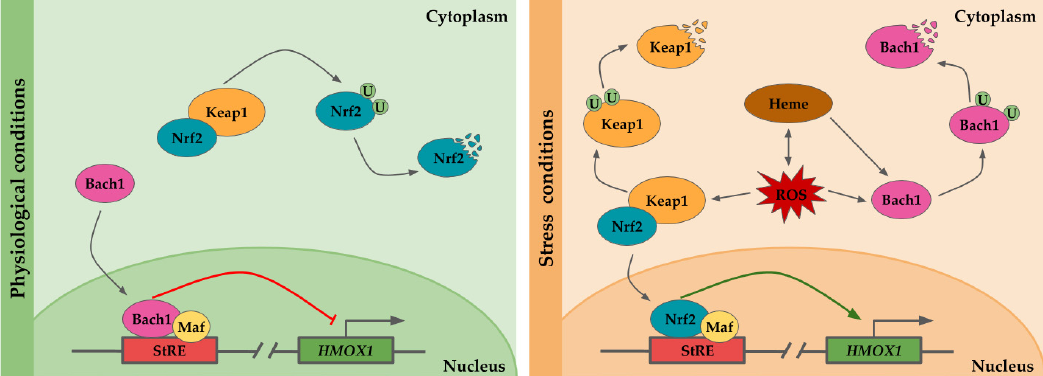
Figure 1. Scheme of the transcriptional regulation of HMOX1 . The HMOX1 gene regulatory region contains several stress response elements (StRE) to which transcription factors binds. Under physiological conditions, the nuclear erythroid 2-related factor (Nrf2) is sequestered in the nucleus by the Kelch-like ECH-associated protein (Keap-1), forming a heterodimer and targeting Nrf2 for ubiquitination and its subsequent proteosomal degradation. The HMOX1 promoter is repressed by Bach1/Maf dimers bound to StRE. Heme is pro-oxidant and generates reactive oxygen species (ROS), which in turn may result in heme release from hemeproteins. In response to stress condition or presence of heme, bach1 translocation to the nucleus is inhibited, and it is targeted for degradation. Upon oxidative stress, Keap1 undergoes a conformational change which induces its ubiquitination and degradation, as well as Nrf2 translocation to the nucleus. Nrf2/Maf dimers transactivate HMOX1 expression by binding to StREs.